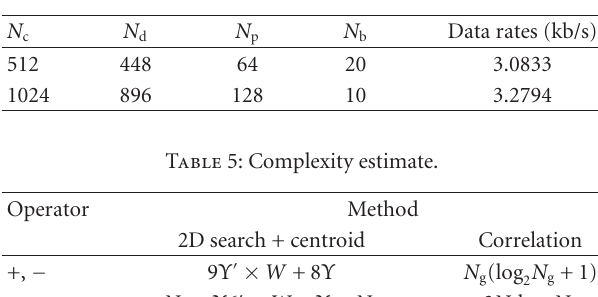
Table 4: OFDM symbol structure and the corresponding data rates.